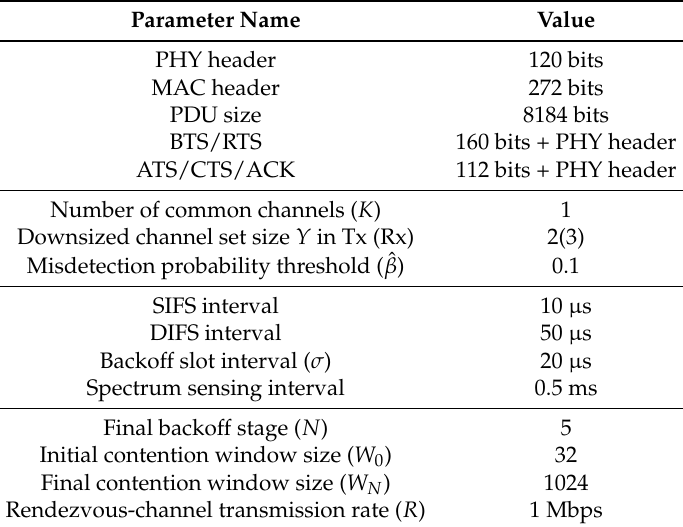
Table 4. Default parameters used in simulations.